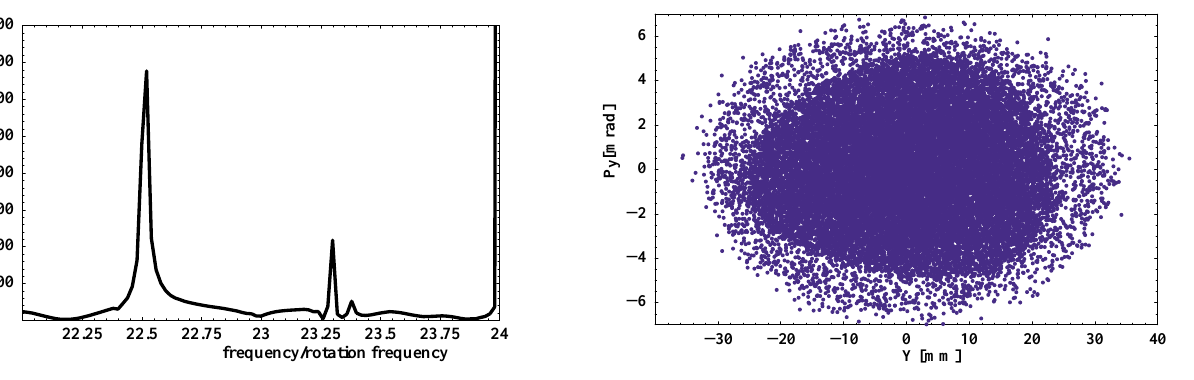
FIG. 18. (Color) Y - P y phase-space plot at 1000 turns for (cid:2) (cid:1) (cid:1) 5.74, 5.71 (cid:2) . (cid:1) n x , n y